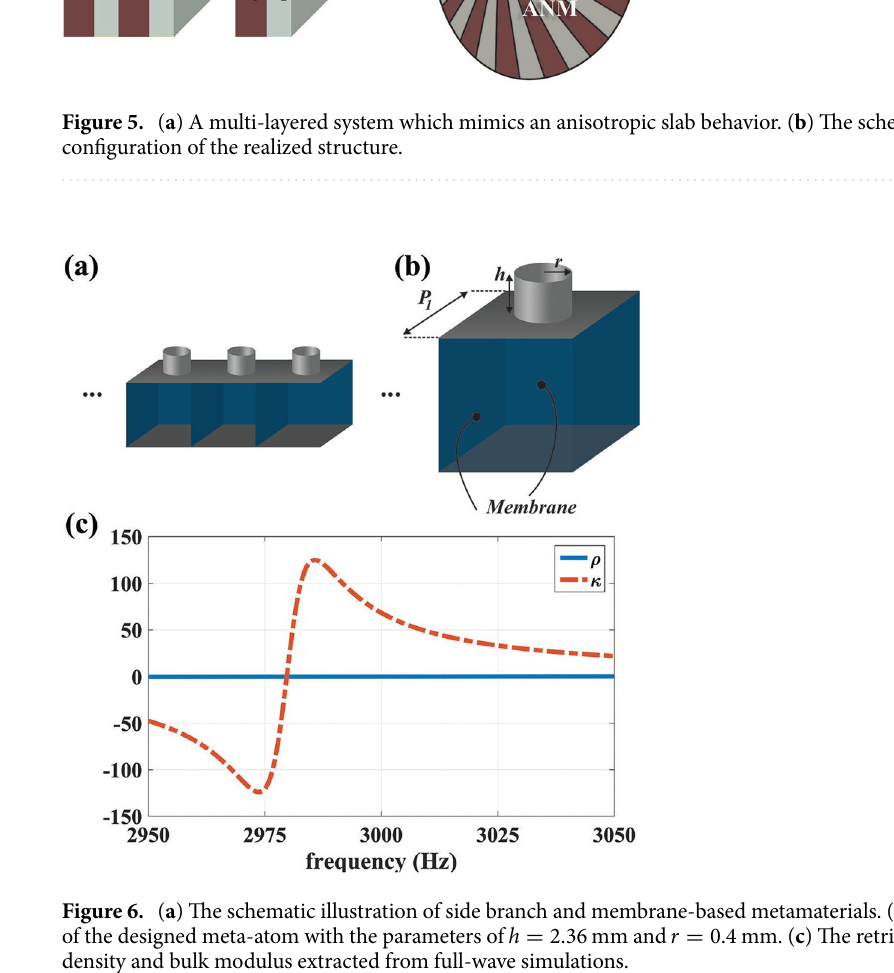
2.36 mm and r 0.4 mm. ( c ) The retrieved relative mass = =